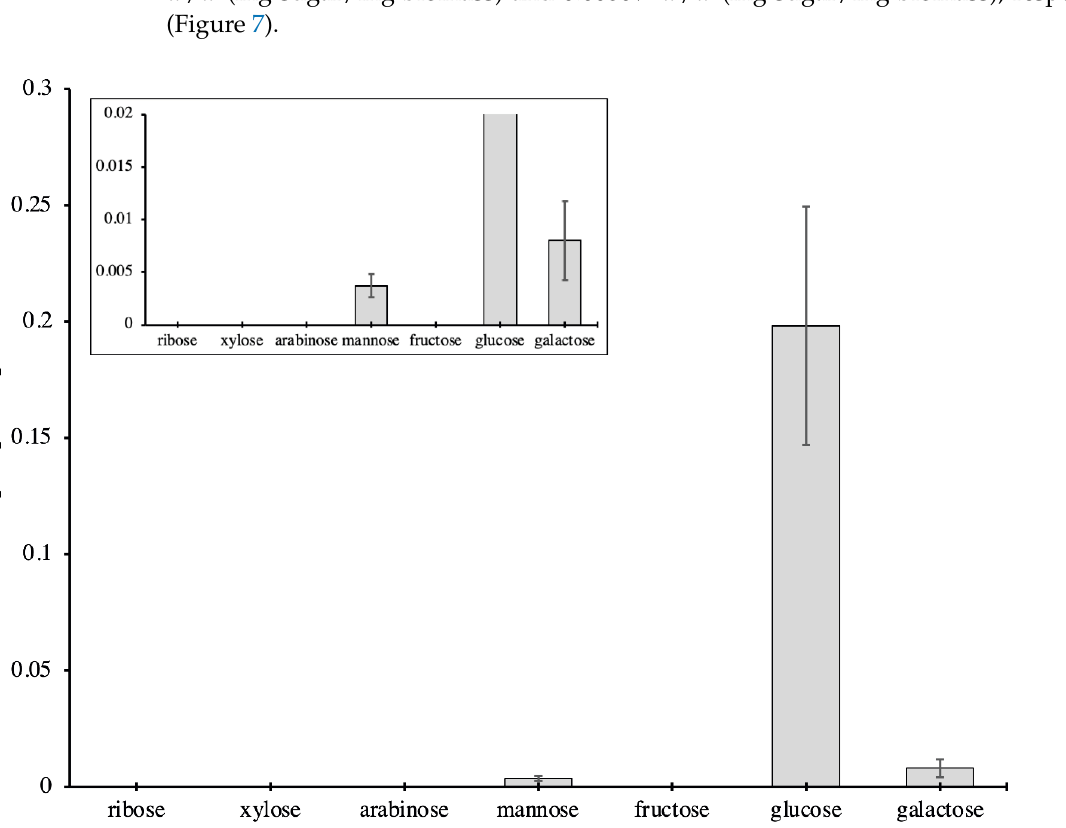
Figure 7. Carbohydrate content of P. bahamense . Sugar profiling of P. bahamense showed glucose as the major constituent (93.0%). Other sugars comprised 7.0% of the total carbohydrate content. Mannose and galactose concentrations were 0.0037% and 0.0080% w / w (mg sugar/mg biomass), respectively. Carbohydrates were extracted from P. bahamense biomass using the phenol–sulfuric acid method, and the corresponding monosaccharides were analyzed using HPLC-MS with multiple reaction monitoring (MRM) detection. Data are presented as mean ± SD of two biological replicates with three technical replicates each.